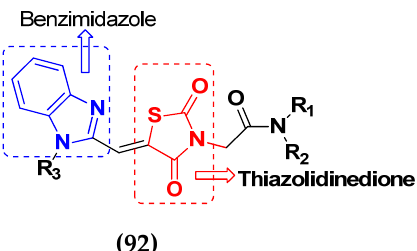
Figure 89. Structure of benzimidazole–thiazolidinedione derivatives ( 92 ).